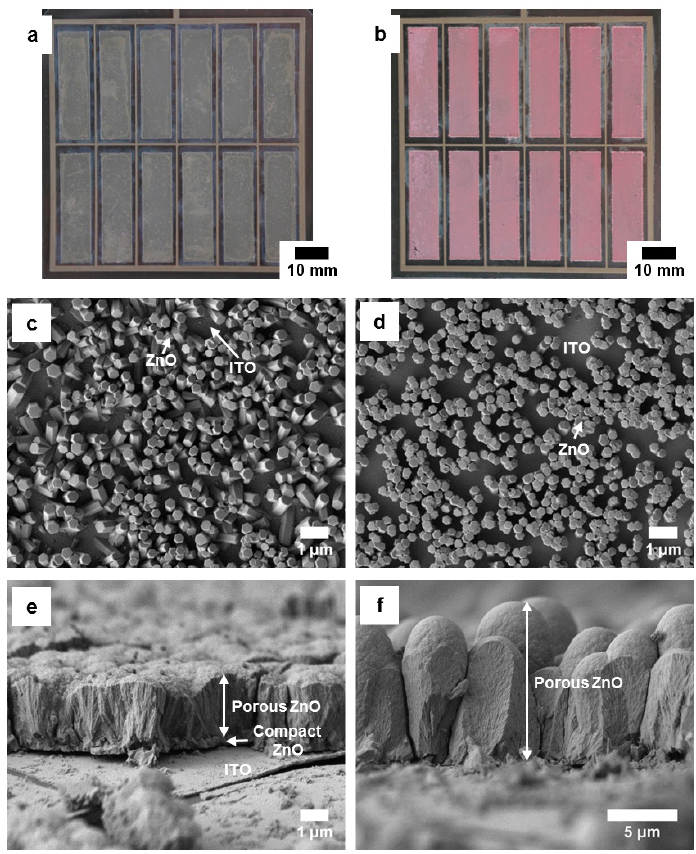
Figure 5. Morphology of ZnO films electrodeposited in the miniplant setup on ITO-PET OC™50 substrates (deposition of compact layer for 20 min and of porous layer for 40 min) and on ITO-PET LR15 substrates (deposition of compact layer for 20 min and of porous layer for 120 min): Photographs of ZnO films after deposition on OC™50 ( a ) and LR15 ( b ); SEM top view images of compact ZnO films deposited on OC™50 ( c ), and LR15 ( d ); SEM cross section images of compact and porous ZnO films deposited on OC™50 ( e ), and LR15 ( f ).